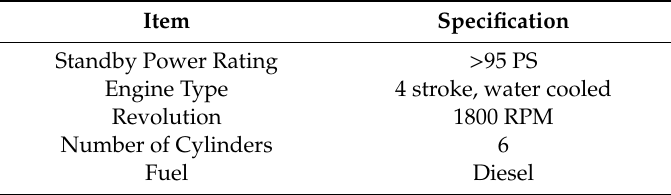
Figure 7. Appearance of diesel generator. Table 3. Major specification of diesel generator engine.